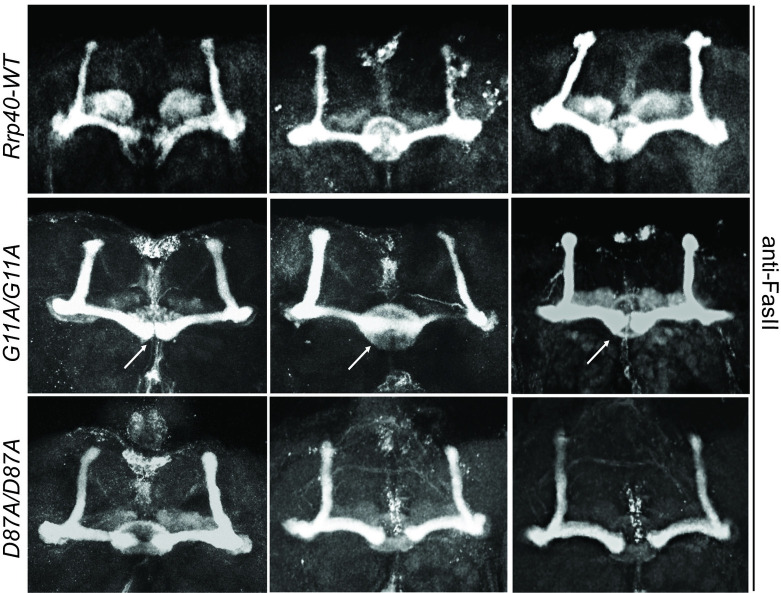
Rrp40G11A mutant flies show defects in mushroom body morphology.Three representative images of merged projections of FasII-stained mushroom bodies from Rrp40-WT control flies (n = 18) (top row), Rrp40G11A (G11A/G11A) mutant flies (n = 23) (middle row), and Rrp40D87A (D87A/D87A) mutant flies (n = 18) (bottom row) are shown. In control flies, β-lobes do not cross the mid-line and well-formed α and β-lobes are readily apparent. In Rrp40G11A mutant flies, 13/23 (57%) brains examined showed defects in β-lobe structure or β-lobe fusion (white arrows). Neither β-lobe defect was detected in the Rrp40D87A mutant flies.